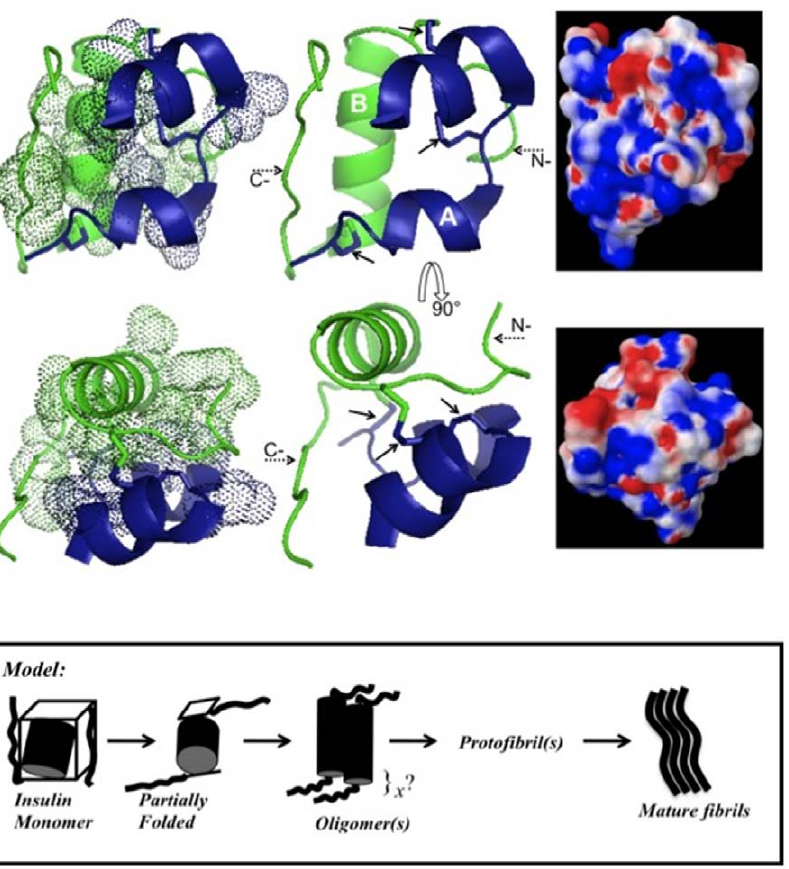
Figure 5. Crystal structure of insulin (PDB ID: 9INS) [ 68 ] with 90 6 rotation. Dark colored (blue) element corresponds to chain-A and light colored (green) to chain-B of insulin in the central structures. The three disulfide bond of insulin have been shown by solid arrows. The dotted arrows indicate the N- and C-terminal segments of chain-B. The dotted spheres on the left hand side of the figure show the central hydrophobic core of insulin. The surface potential of insulin molecule (blue - positive; red – negative) obtained after processing by PDB2PQR [69] and APBS [70] has been shown on the right hand side of the figure. The proposed model of insulin fibrillation is depicted at the bottom of the figure (see text for details).